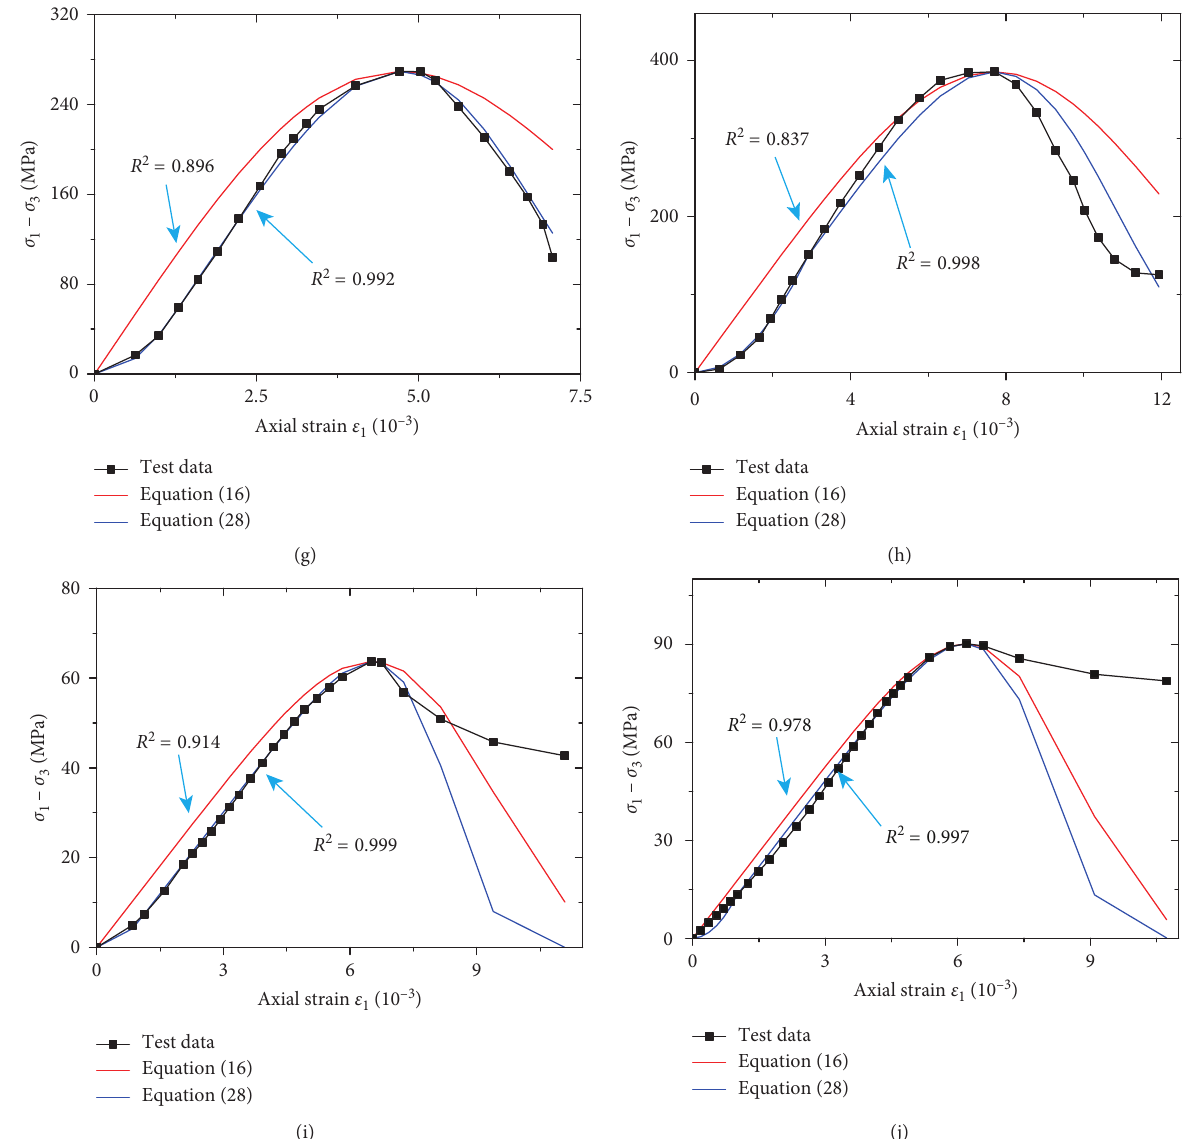
Figure 9: The comparison of the theoretical curve and the test data. ∗ Equation (16) is the statistical damage constitutive model from [26], and (28) is the statistical damage constitutive model we proposed; the specimen numbers correspond to Table 2. (a) No.1. (b) No. 2. (c) No. 3. (d) No. 4. (e) No. 9. (f) No. 10. (g) No. 13. (h) No. 17. (i) No. 19. (j) No.